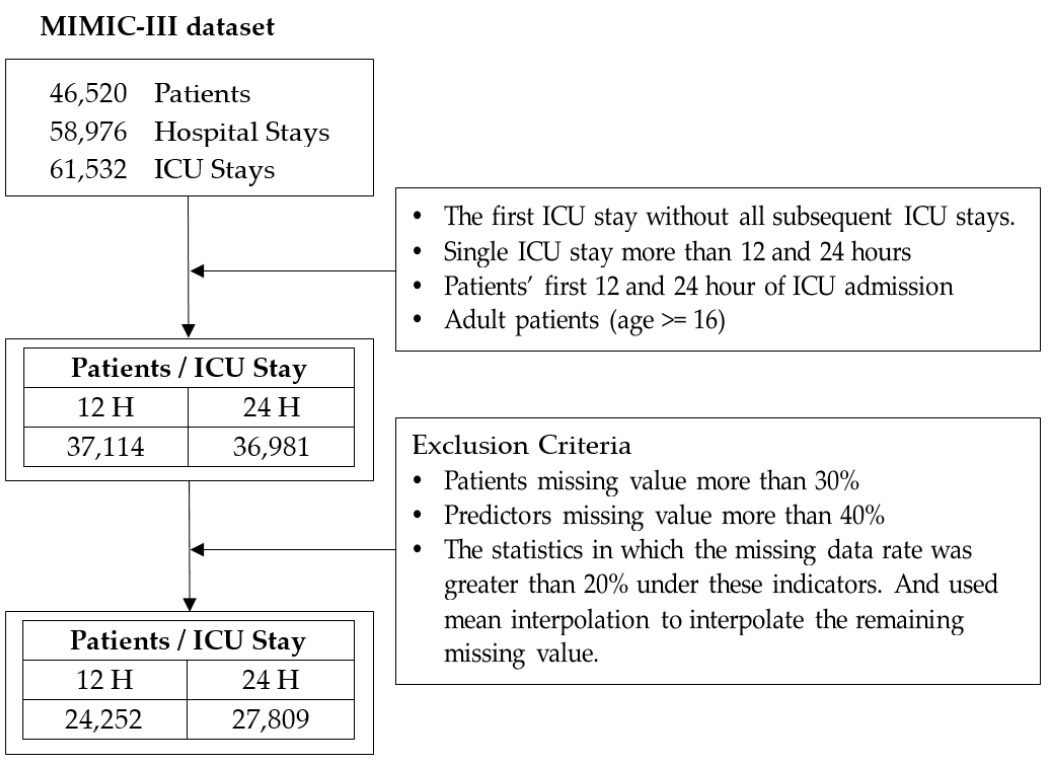
Figure 2. LDA model framework.